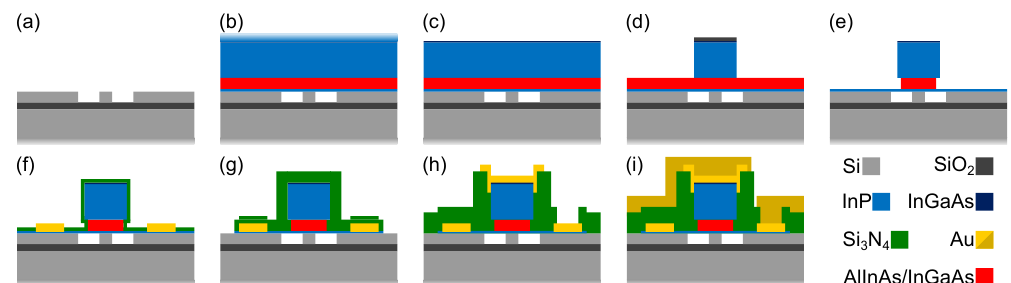
Figure 2. Processing steps: ( a ) gratings and Si waveguides are defined; ( b ) the QCL chip is bonded to the Si wafer; ( c ) the InP substrate is removed; ( d ) top contact and cladding layers are dry etched; ( e ) the active region is wet etched; ( f ) the bottom contact region is defined and gold is deposited; ( g ) Si 3 N 4 is deposited and the bottom contact layer is etched; ( h ) vias are etched and the top contact metal is deposited; ( i ) probe metal is